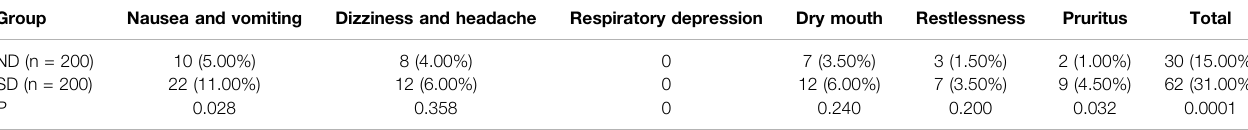
Statistical analysis was performed by chi-square test or Fisher ’ s exact